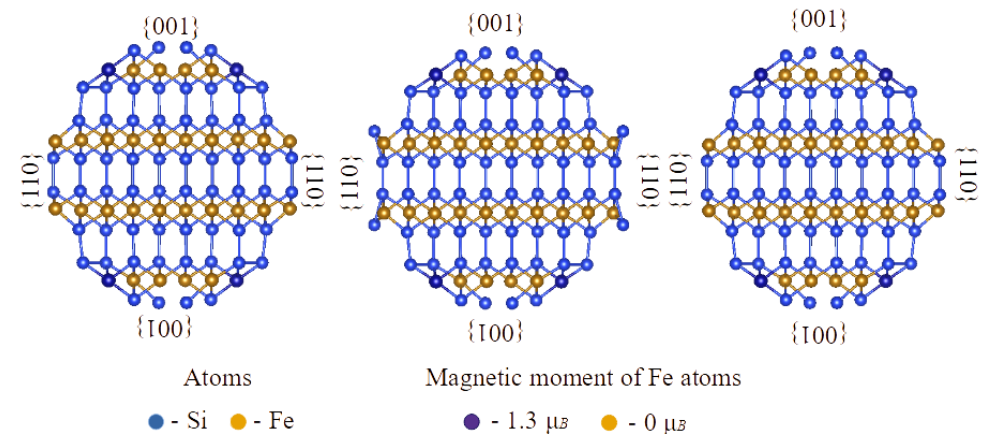
Figure 7. Cross sections of <110>-oriented α -FeSi 2 NWs with the different morphologies indicating surface Fe atoms with magnetic moments. All facets are shown.